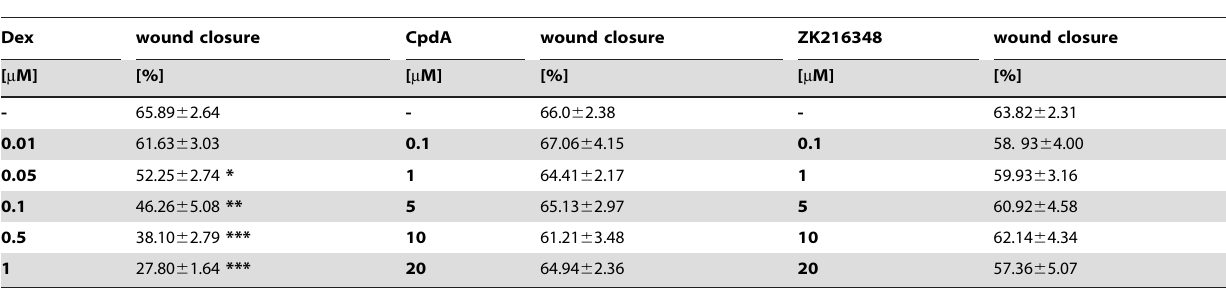
Table 1. Effect of SEGRAs on HaCaT cell restitution.